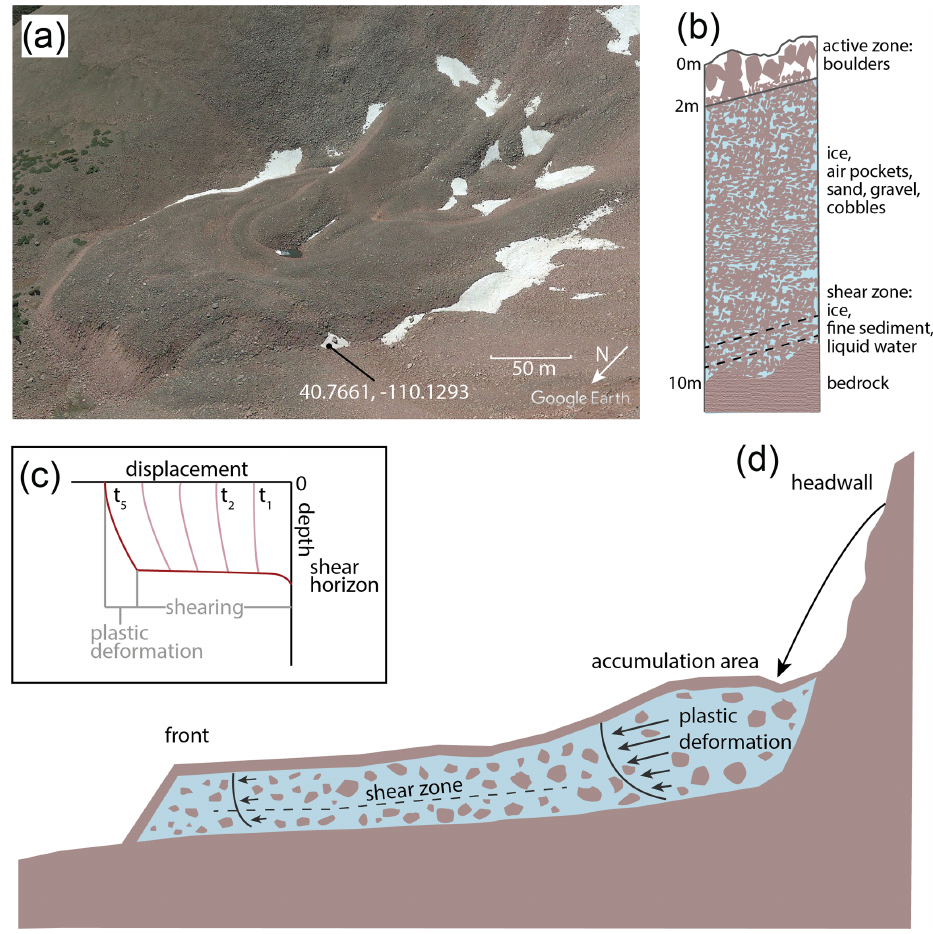
Figure 1. Figure showing general internal structure and deformation of rock glaciers. (a) Oblique view of a Uinta rock glacier from © Google Earth. (b) Schematic stratigraphic cross section of a rock glacier in the Uinta Mountains. Schematic diagram is based on borehole data from Arenson et al. (2002). (c) Plot showing how total displacement is related to shearing and plastic deformation in rock glaciers. Deformation primarily occurs along shear horizons within rock glaciers. (d) Schematic showing rock glacier deformation ( c and d based on Kenner et al.,